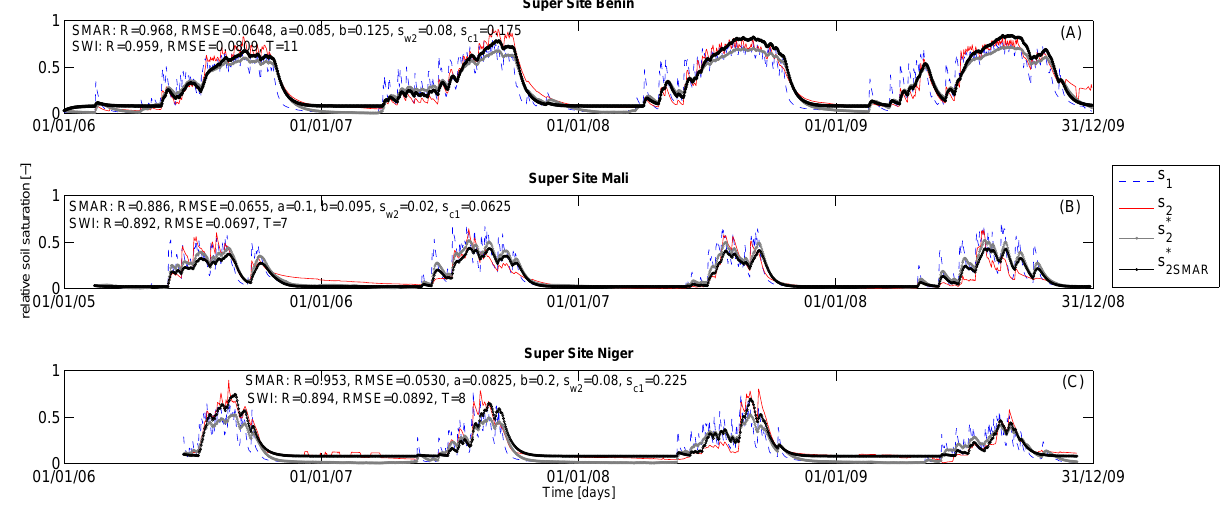
) for three super sites located 2